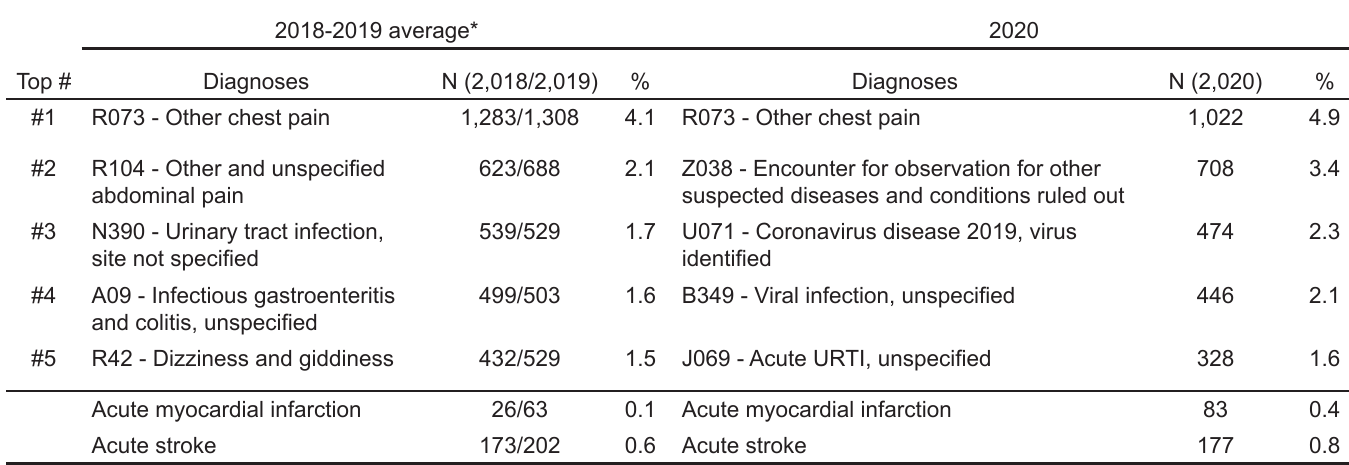
URTI , Upper respiratory tract